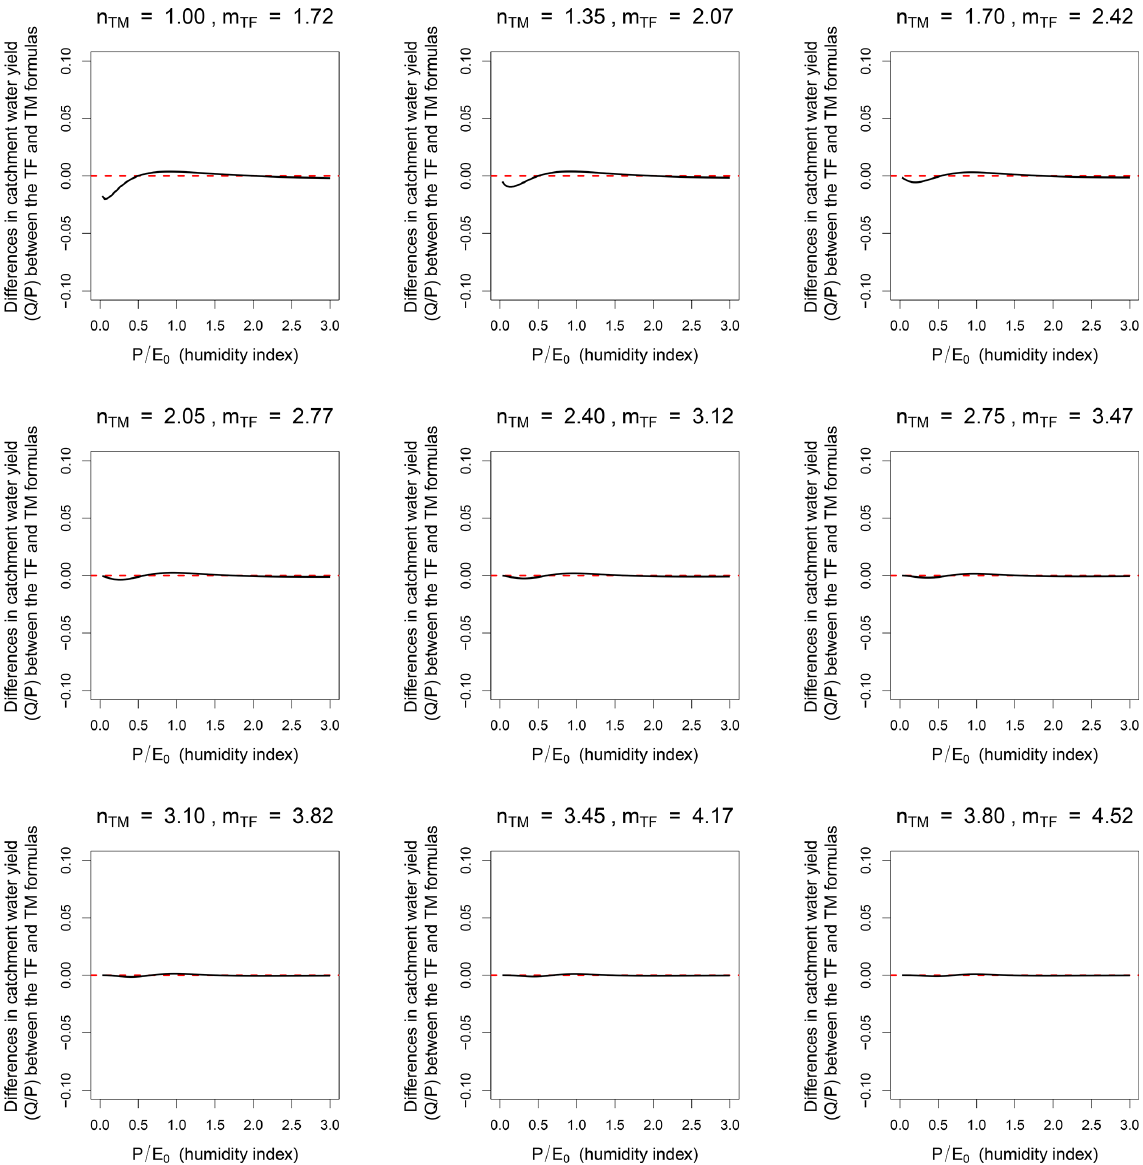
Figure 1. Illustration of the similarity between the values of the Turc–Mezentsev (TM) and Tixeront–Fu (TF) formulas for a range of values of n (the parameter of the TM formula) and m (the parameter of the TF formula), using the Yang et al. (2008) relationship: m = n + 0 .